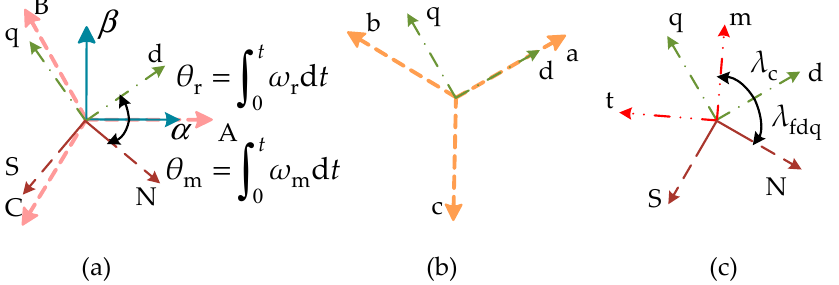
Figure 3. The relationship between the coordinate systems: ( a ) the relationship between the static stator three-phase coordinate system, the static stator two-phase coordinate system and the rotor dq coordinate system; ( b ) the relationship between the rotor dq coordinate system and the rotor three- phase coordinate system; ( c ) the relationship between the rotor dq coordinate system and the syn- chronous mt coordinate system.